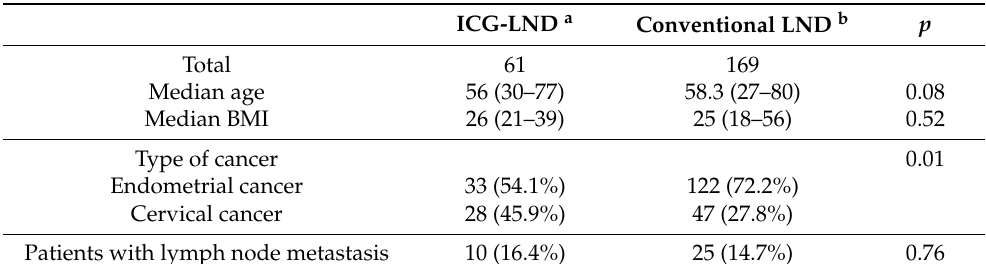
Table 1. Clinical characteristics of the investigated